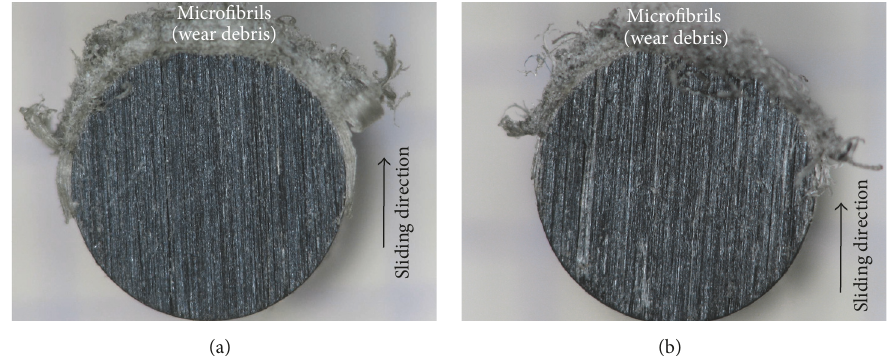
Figure 5: Photomacrograph of worn PA6/6-surface (counterface P240 and 20 N normal force): (a) extruded pins; (b) injection moulded pins.